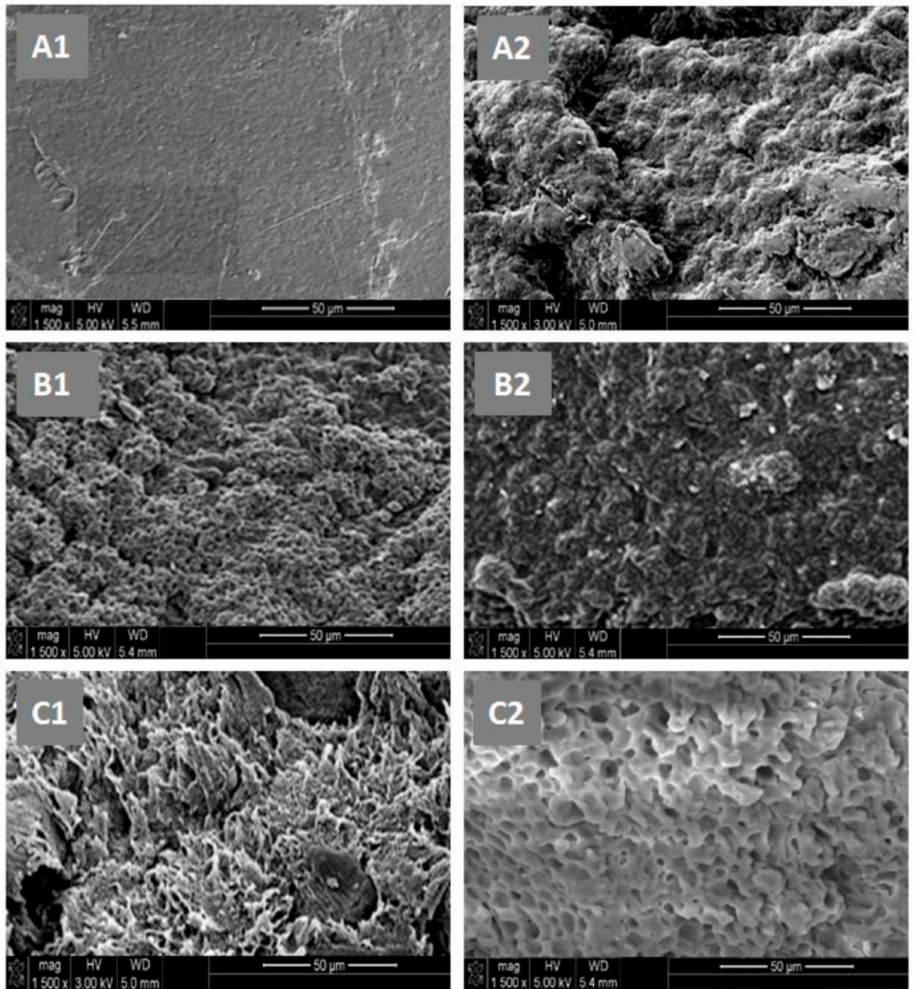
Figure 11. SEM micrographs of the surface morphologies of ASP-2/PE- co -VAL/P δ -VL50 system ( left ) and ASP-7/PE- co -VAL/P δ -VL75 system ( right ) before ( A1 and A2 ) and after the release process in neutral media pH ( B1 and B2 ) and in media pH 1 ( C1 and C2